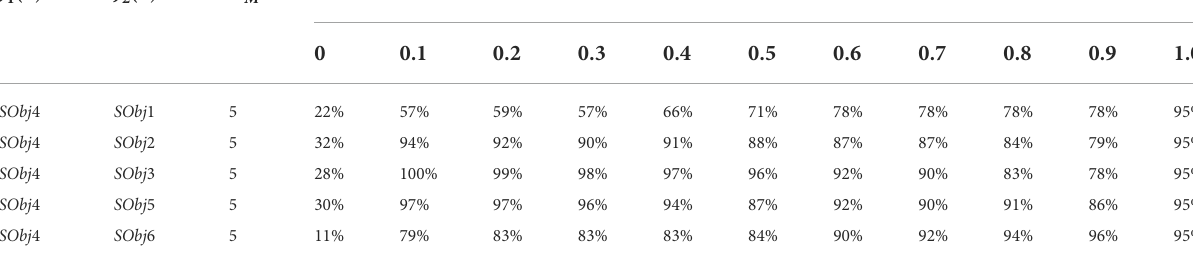
TABLE 2 DVC100 values of SDD results in case 3 based on varying w and N M = 5.